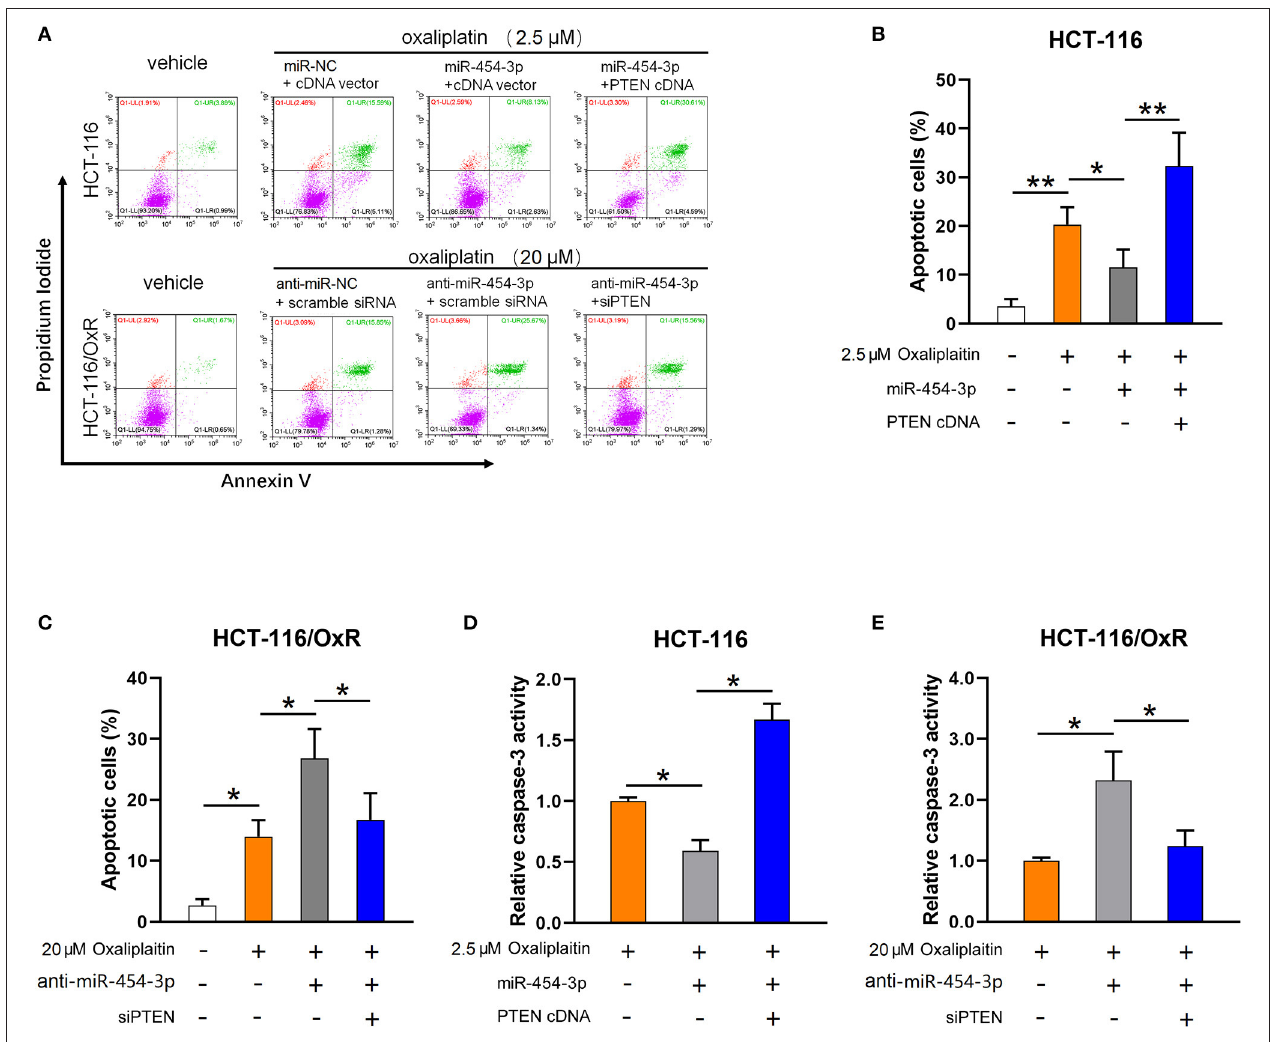
FIGURE 4 | MiR-454-3p attenuates oxaliplatin-induced cell apoptosis through down-regulation of PTEN. (A–C) Cell apoptosis qualified by flow cytometry after annexin V–FITC and PI double staining in indicated cells treated with different concentrations of oxaliplatin. (D,E) Analysis of caspase-3 activity in indicated cells treated with different concentrations of oxaliplatin. Results were presented as mean ± SD from three independent experiments. * P < 0.05, ** P <